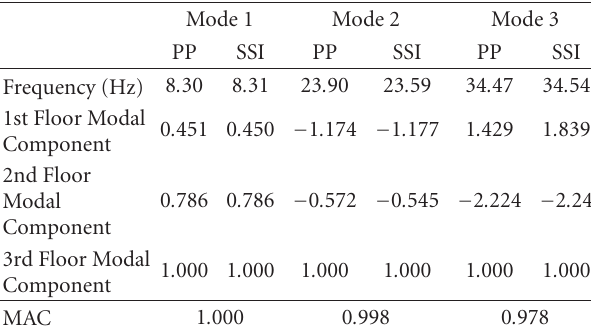
Table 2: Comparison of identified modal frequencies and mode shapes.